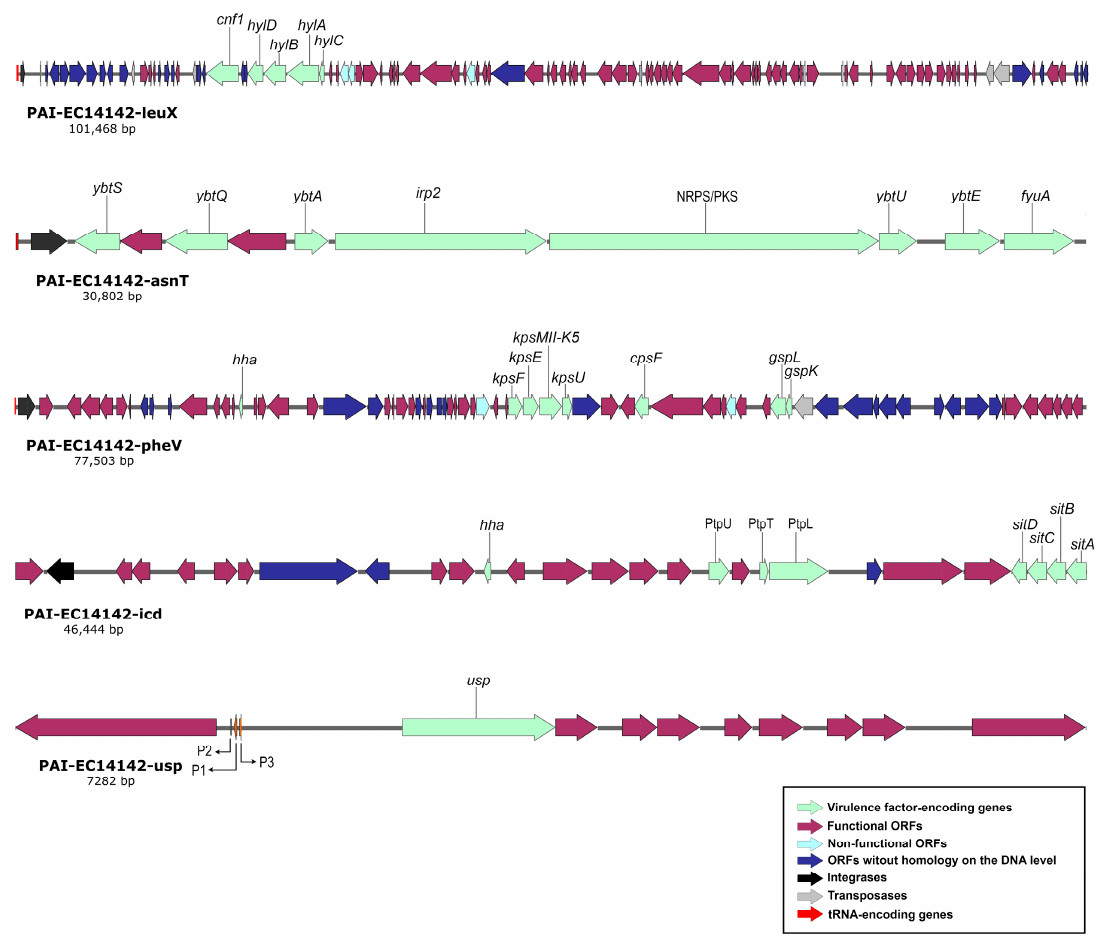
Figure 2. Schematic genetic representation of PAIs: PAI-EC14142-leuX, PAI-EC14142-asnT, PAI- EC14142-pheV, PAI-EC14142-icd, and PAI-EC14142-usp belonging to UPEC EC14142 isolate. The arrows indicate open reading frames (ORFs) with the green, purple, light blue, navy blue, black, grey, and red parts representing virulence factor-encoding genes, functional ORFs, non-functional ORFs (e.g., due to internal stop codons or frameshifts), ORFs without homology on the DNA level, integrases, transposases, and tRNA-encoding genes,